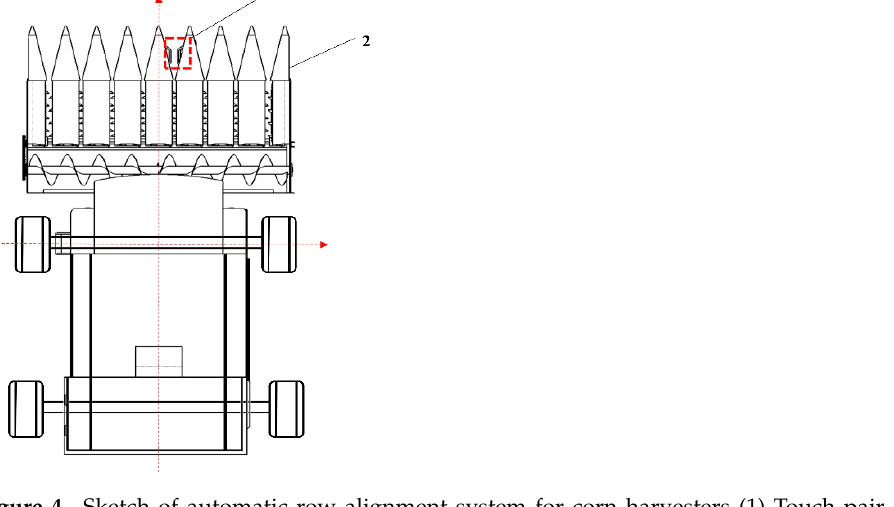
Figure 4. Sketch of automatic row alignment system for corn harvesters (1) Touch pair of line mechanism (2) Cutting table.